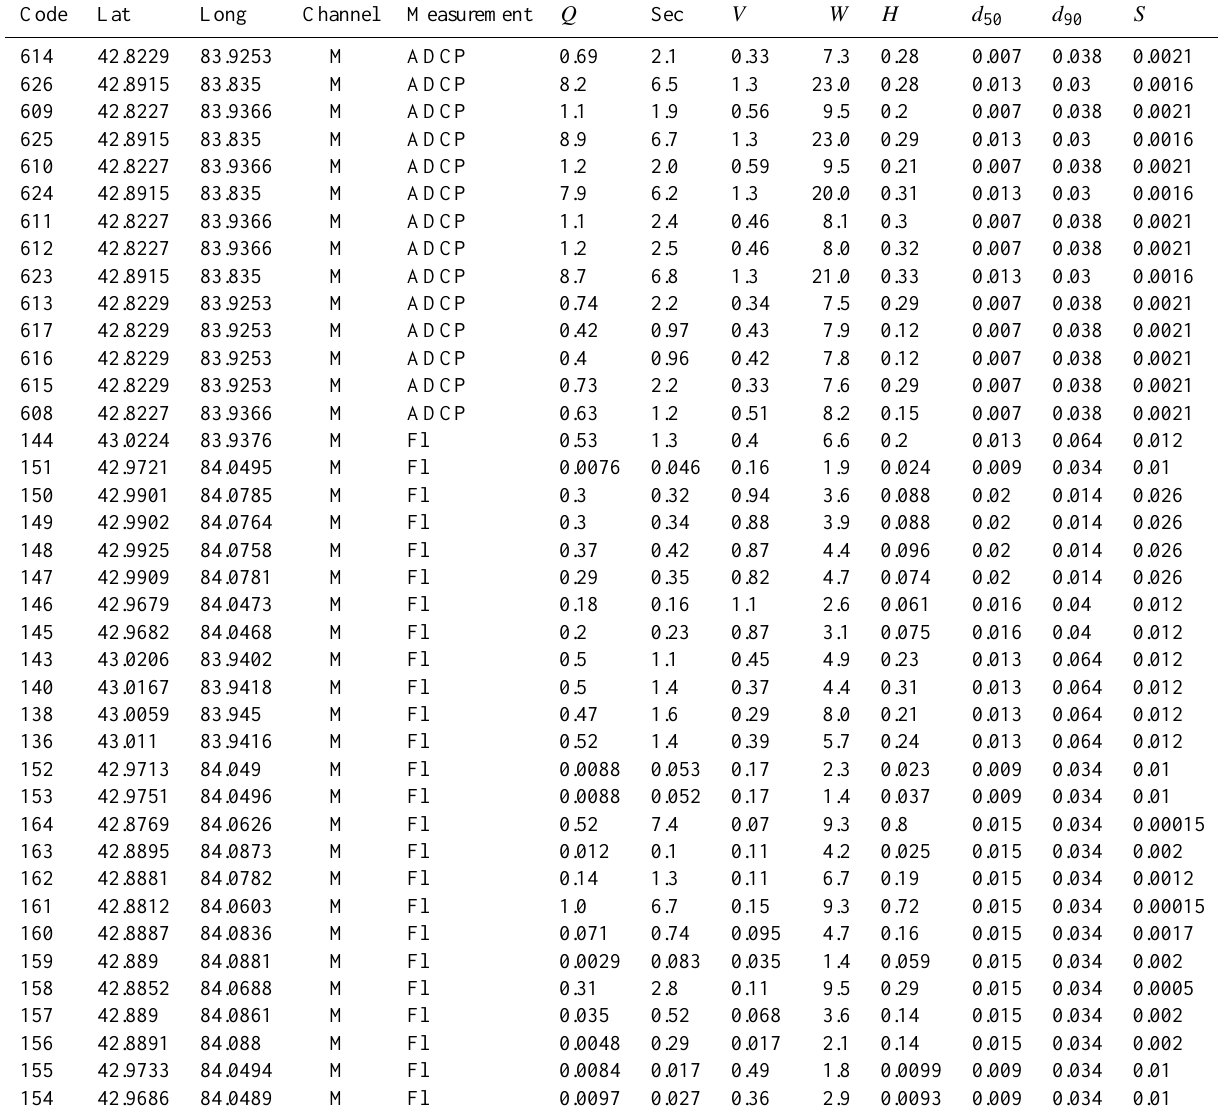
Table 2. Data gathered for meandering-river threads. Latitude (lat) and longitude (long) are in degrees centesimal; measurement stands for measurement type (Fl: float, ADCP: acoustic doppler current profiler); Q : discharge, Sec: wetted area, V : average velocity, W : width, H : depth, d 50 : median grain size, d 90 : size of the 90th percentile, S : slope. All physical quantities are given in the International System of